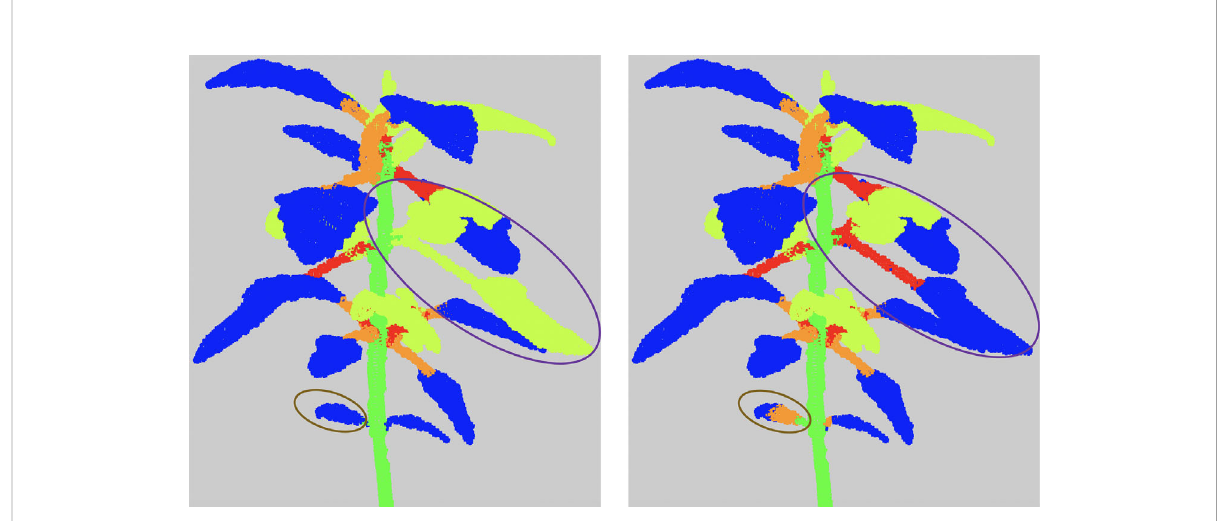
FIGURE 7 Examples of results of the re fi nement algorithm, when clusters detected as False are clustered again. The purple circle shows a leaf together with an apex and its branch that were classi fi ed in the semantic class ( Apex). The brown circle shows a cotyledon. As it is not detected differently from the leaf blades, the algorithm considered that the leaf blade of the cotyledon was directly connected to the main stem and therefore clustered it